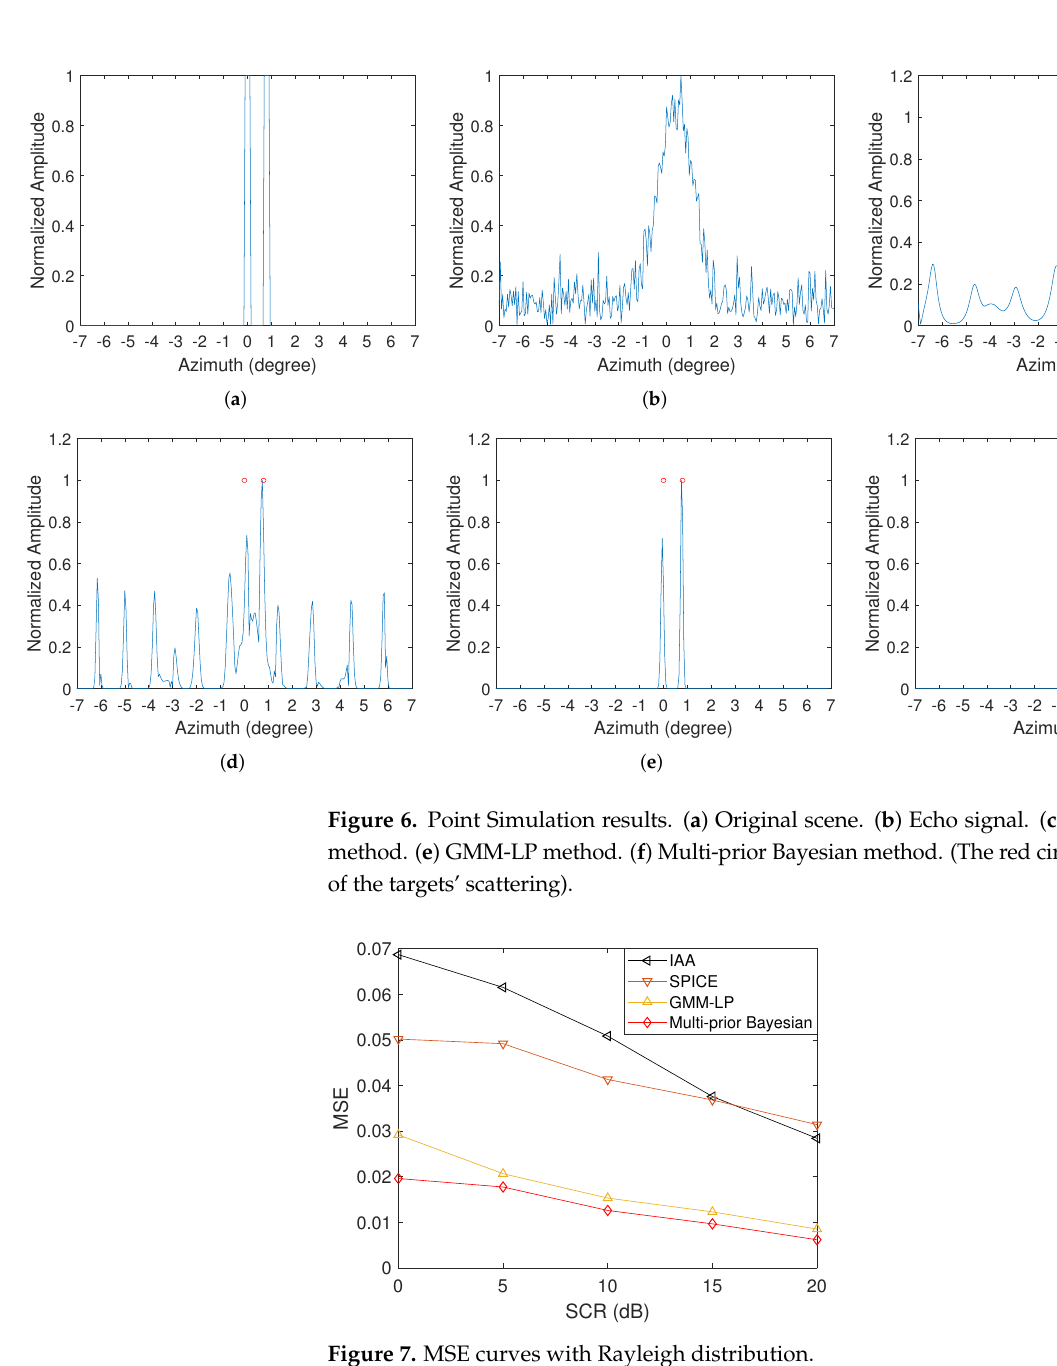
Figure 7. MSE curves with Rayleigh